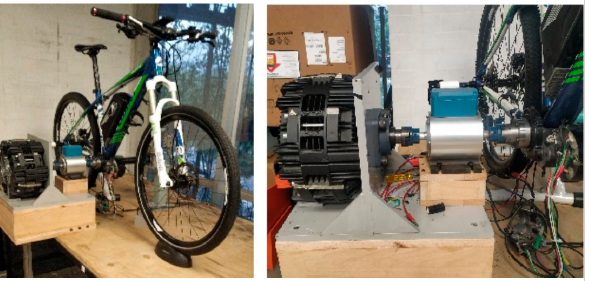
Figure 2. Controller, motor, and reduction gears (CMRGs) experimental